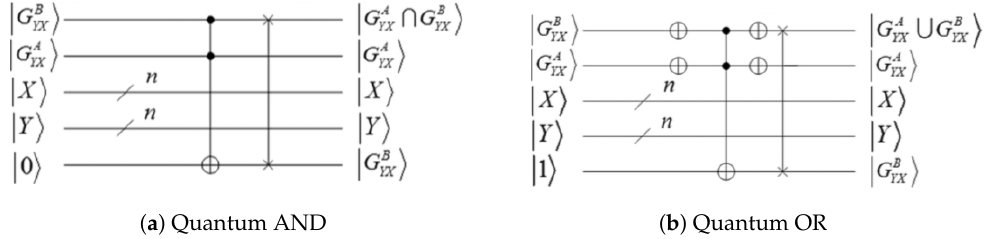
Figure 3. The quantum circuits for AND and OR operations where X and Y represent the position information (See the definition of the symbols in Figure 2).